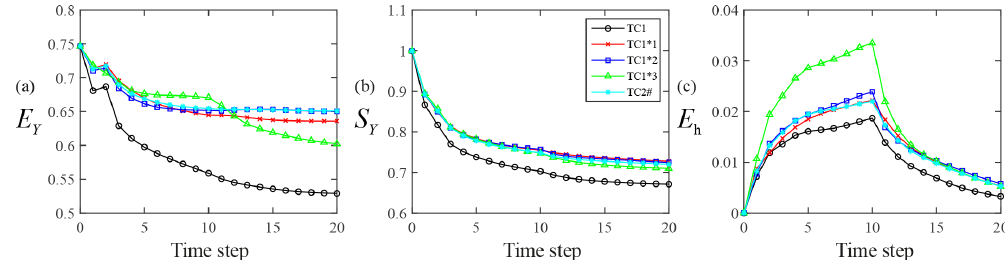
Figure 9. Temporal evolution of E Y (a) , S Y (b) , and E h (c) for TC1 ∗ 1, TC1 ∗ 2, TC1 ∗ 3, TC1, and TC2#.